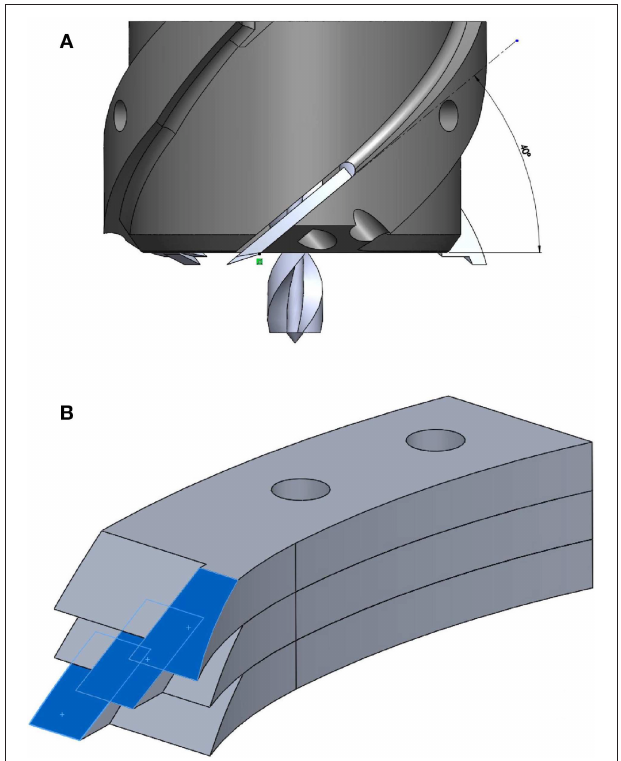
FIGURE 3 | (A) The 3D-printed cutting head features three 40 ◦ cutting teeth. (B) The cutting teeth are staggered to reduce